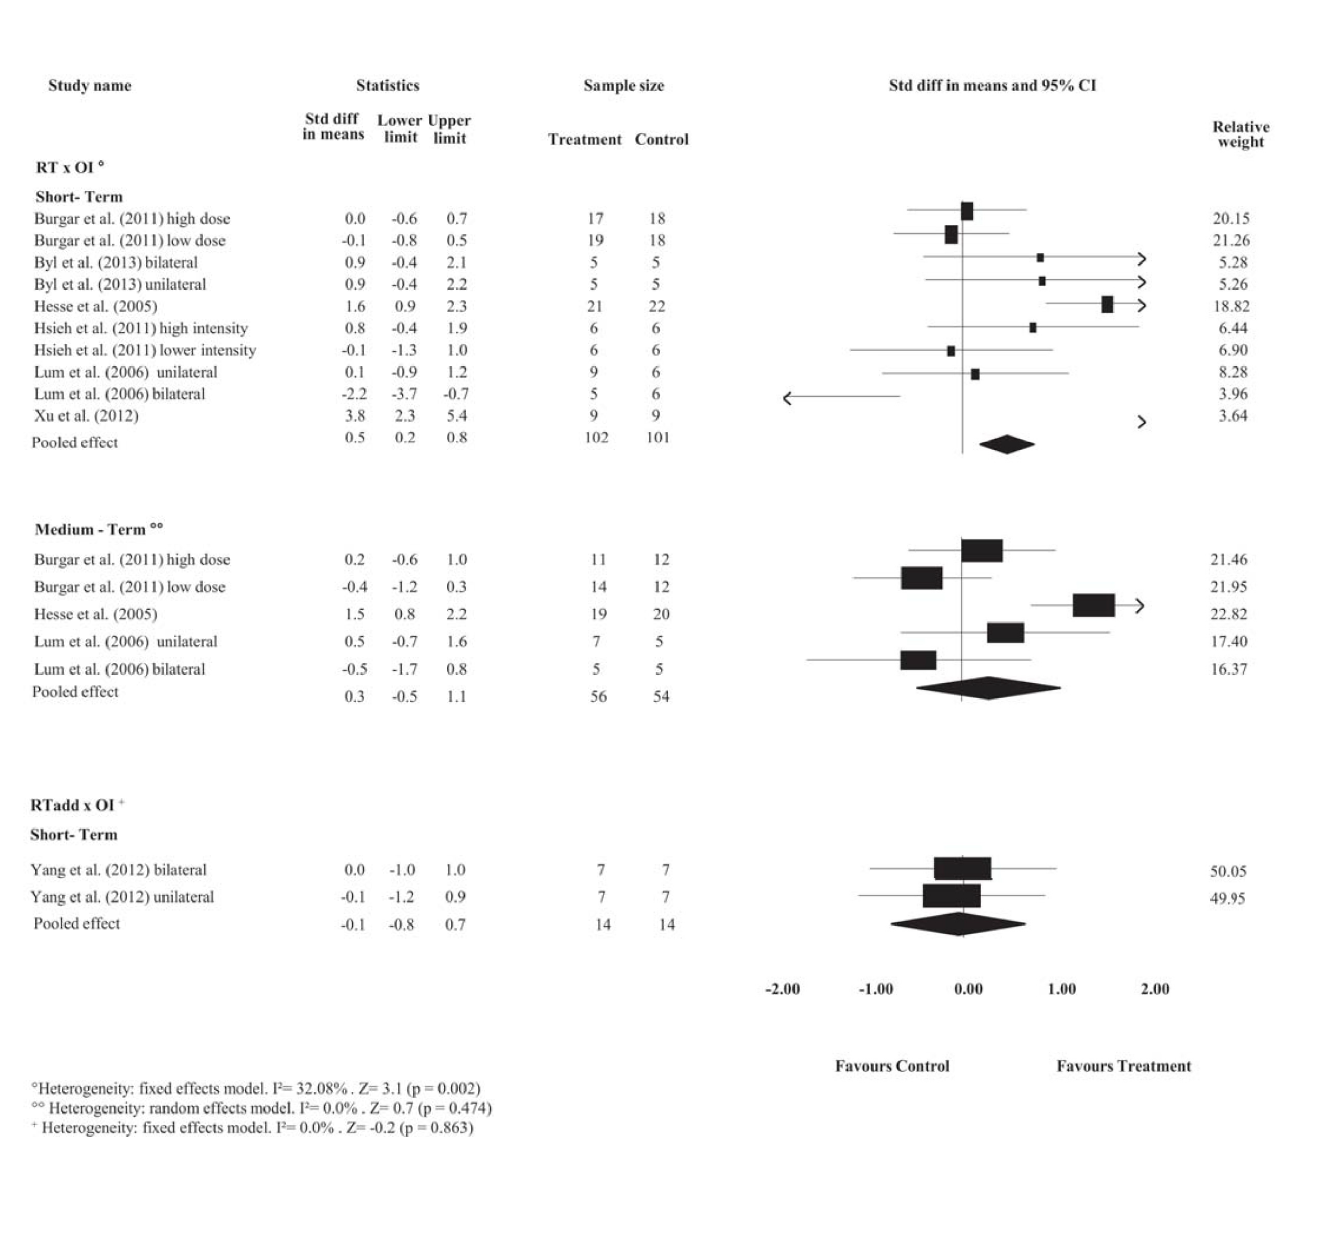
Fig 4. Standardized mean difference (95% CI) comparing RT versus OI for strength in people with limited upper limb function. RT = Robot-assisted therapy; OI = other intervention.